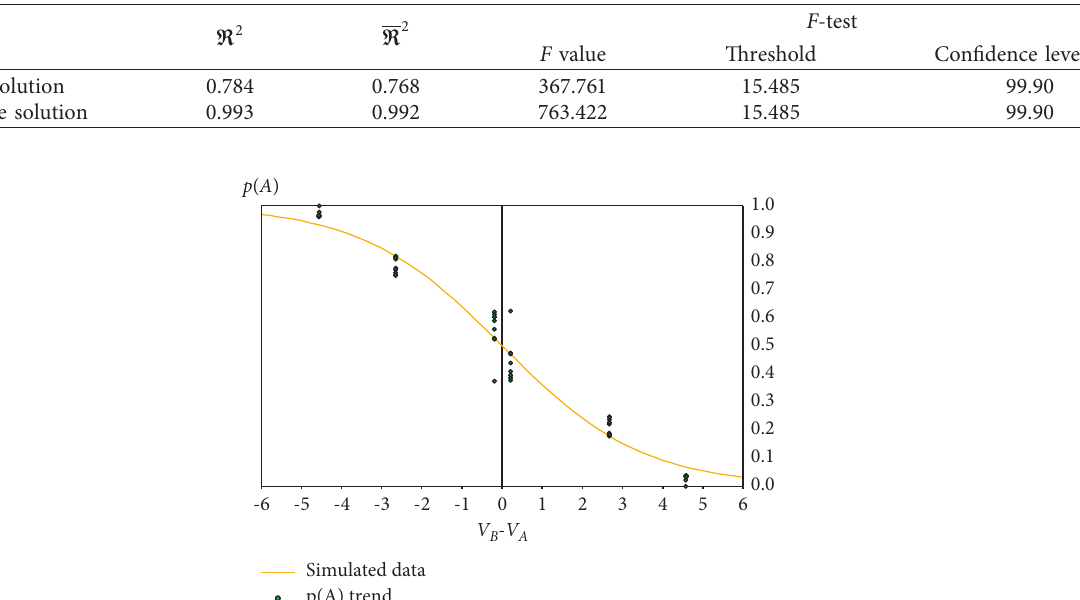
Table 7: Global statistical tests in the case of the route choice model.